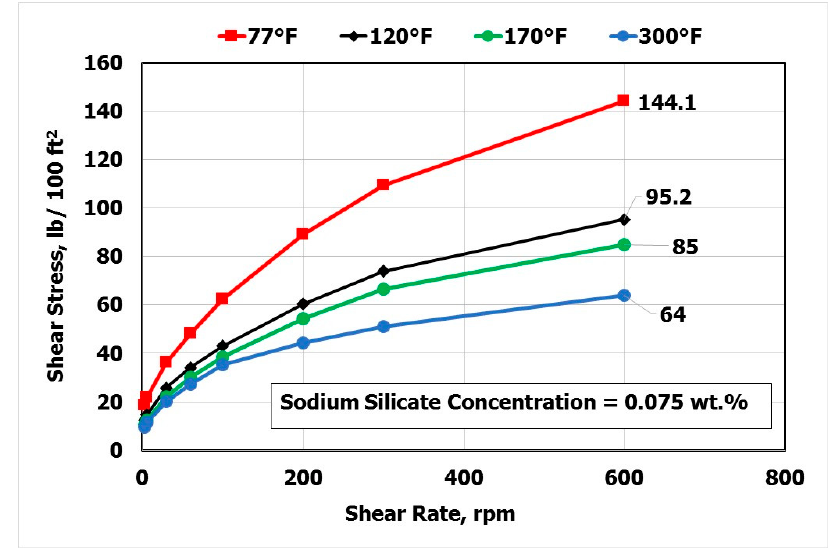
Figure 3. Effect of temperature on the shear stress–shear rate behavior of the drilling fluid with 0.075 wt.% SS.